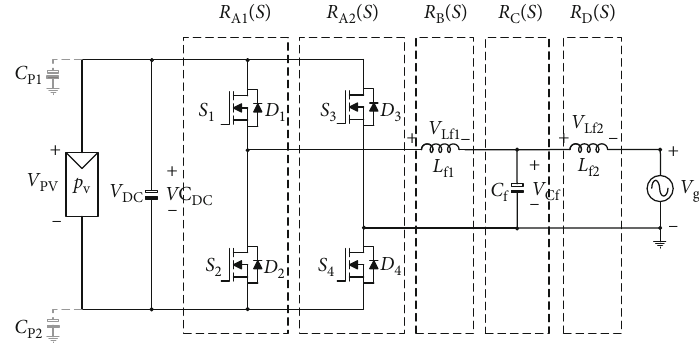
Figure 6: Full bridge with coupling LCL fi lter.